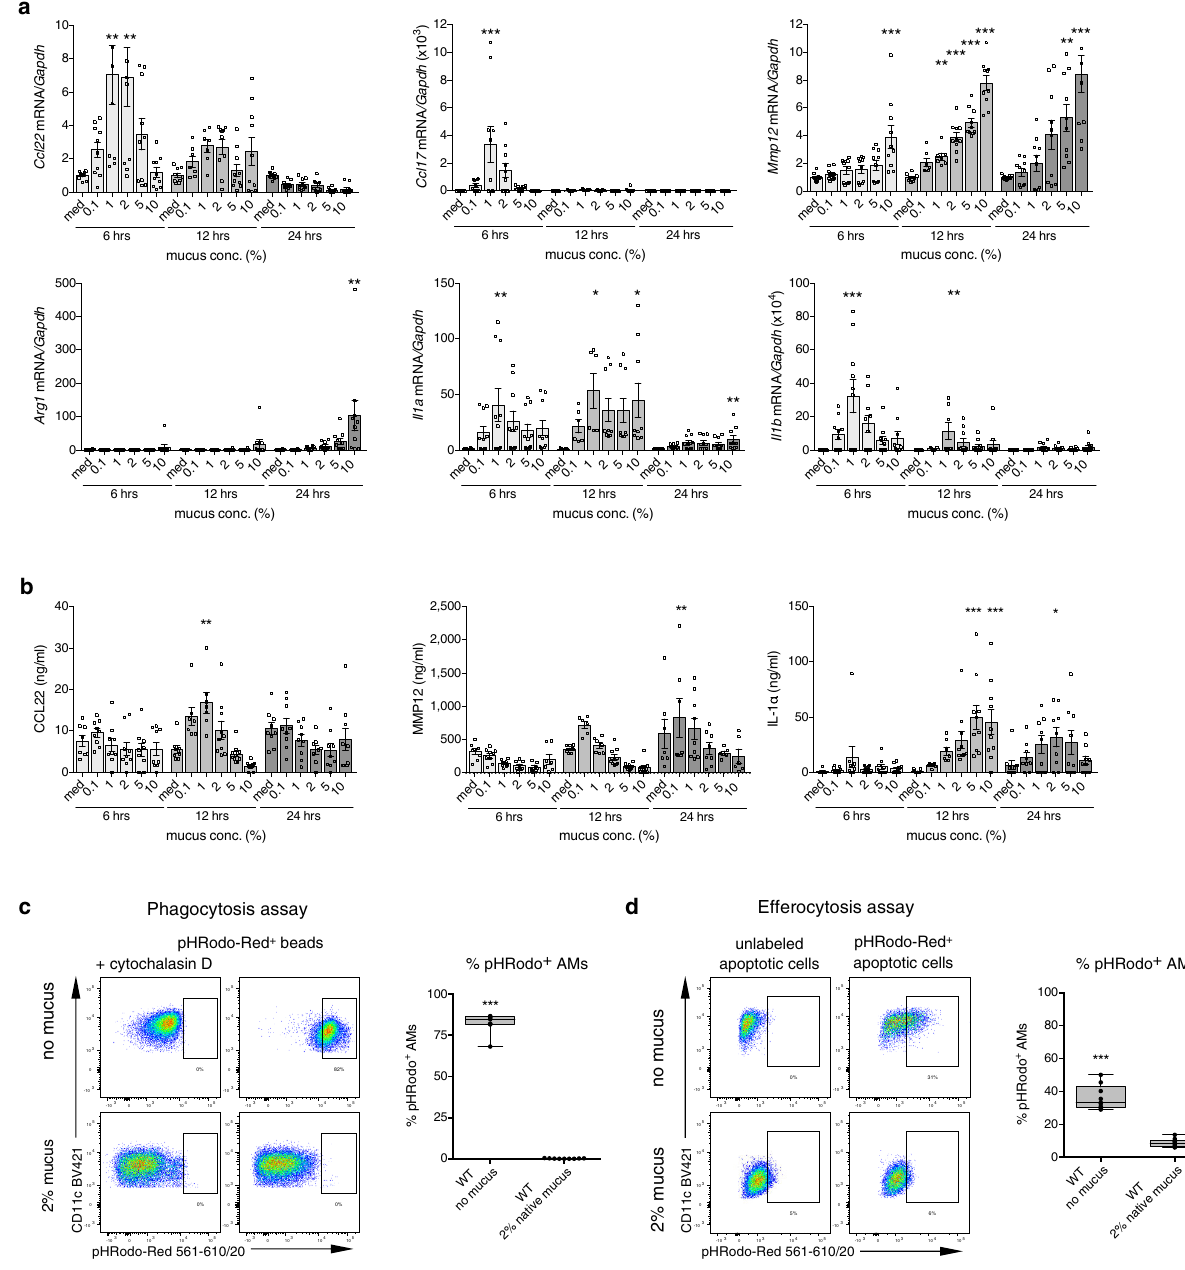
Fig. 6 Mucus triggers AM immune responses and functions. a Gene expression levels of Ccl22 , Cccl17 , Arg1 , Mmp12 , Il1a , and Il1b , and b protein expression levels of CCL2, MMP12, and IL-1 α in the supernatant of wild-type (WT) airway macrophages (AM) treated with increasing mucus concentrations or medium (med) for 6, 12, and 24 h (hrs). Representative fl ow cytometry plots and percentage of pHRodo + AMs, depicting c phagocytosis and d efferocytosis capacities of AMs treated with 2% mucus or medium. Bar plots show mean ± SEM of a 6, 24 h: n = 10 per group. 12 h: n = 9 (med), n = 7 (0.1, 1%), n = 10 Ccl22, Ccl17, Mmp12, Arg1, Il1b (2, 5, 10%), n = 9 Il1a (2, 5, 10%), and b 6 h: n = 8 (CCL22, MMP12, med), n = 7 (IL-1 α , med), n = 9 (0.1, 1%), n = 9 (CCL22, IL-1 α , 2%), n = 8 (MMP12, 2%), n = 9 (CCL22, IL-1 α , 5%), n = 6 (MMP12, 5%), n = 9 (CCL22, IL-1 α , 10%), n = 7 (MMP12, 10%). 12 h: n = 9 (med), n = 7 (CCL22, IL-1 α , 0.1%), n = 6 (MMP12, 0.1%), n = 7 (1%), n = 10 (2, 5, 10%). 24 h: n = 9 (CCL22, IL-1 α , med), n = 7 (MMP12, med), n = 9 (CCL22, IL-1 α , 0.1%), n = 7 (MMP12, 0.1%), n = 9 (1%), n = 8 (CCL2, MMP12, 2%), n = 9 (IL-1 α , 2%), n = 8 (CCL2, IL-1 α , 5%), n = 6 (MMP12, 5%), n = 9 (CCL22, IL-1 α , 10%), n = 6 (MMP12, 10%). * P value < 0.05; ** P value < 0.01; *** P value < 0.001 by one-way ANOVA following Bonferroni´s post hoc test. Box plots indicate the largest value within the 1.5× interquartile range above 75th percentile, 75th percentile, median, 25th percentile, and smallest value within the 1.5× interquartile range below 25th percentile of c , d n = 9 per group. * P value < 0.05; ** P value < 0.01; *** P value < 0.001 by Mann – Whitney U -test. Source data are provided as a Source Data fi